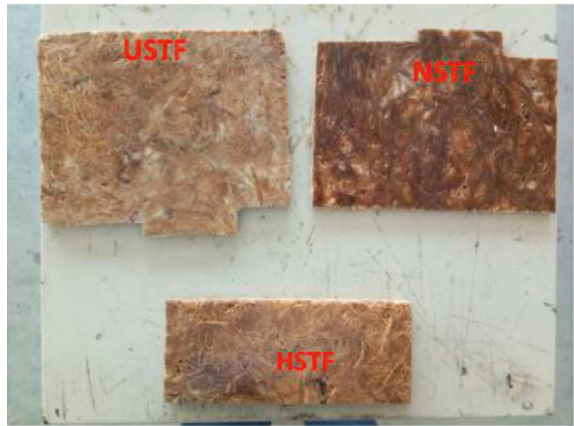
Figure 3: Prepared composite materials.